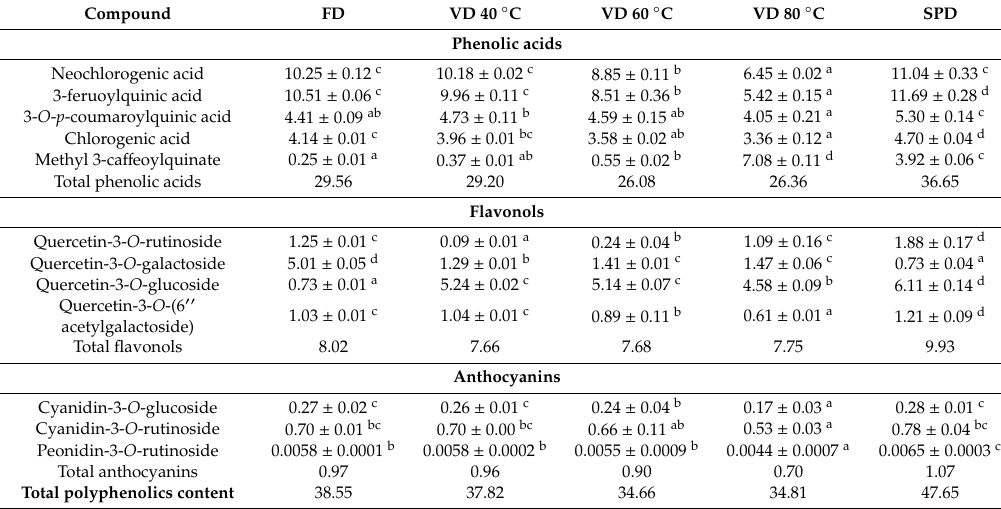
Table 2. Content of identified major phenolic compounds in plum extracts powders (PEP) obtained by selected drying methods (g / 100 g